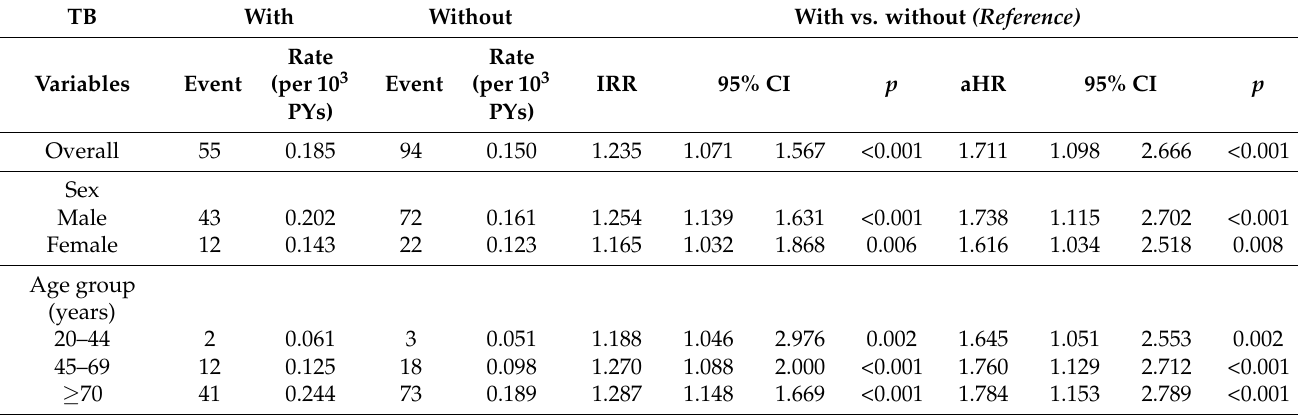
Table 3. Incidence and aHR for aortic aneurysm and aortic dissection in the TB and non-TB cohorts stratified by sex, age, socioeconomic status, and comorbidities.